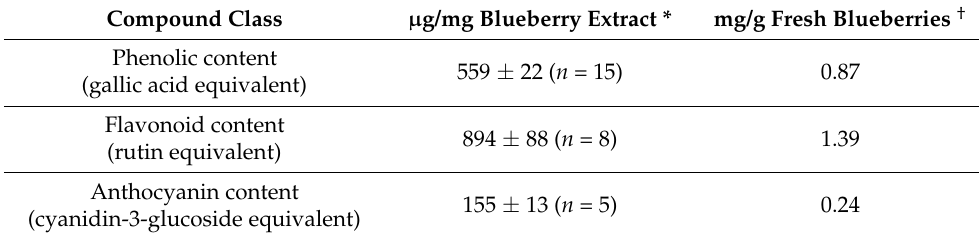
Table 1. Total phenolics, flavonoids, and anthocyanins content in